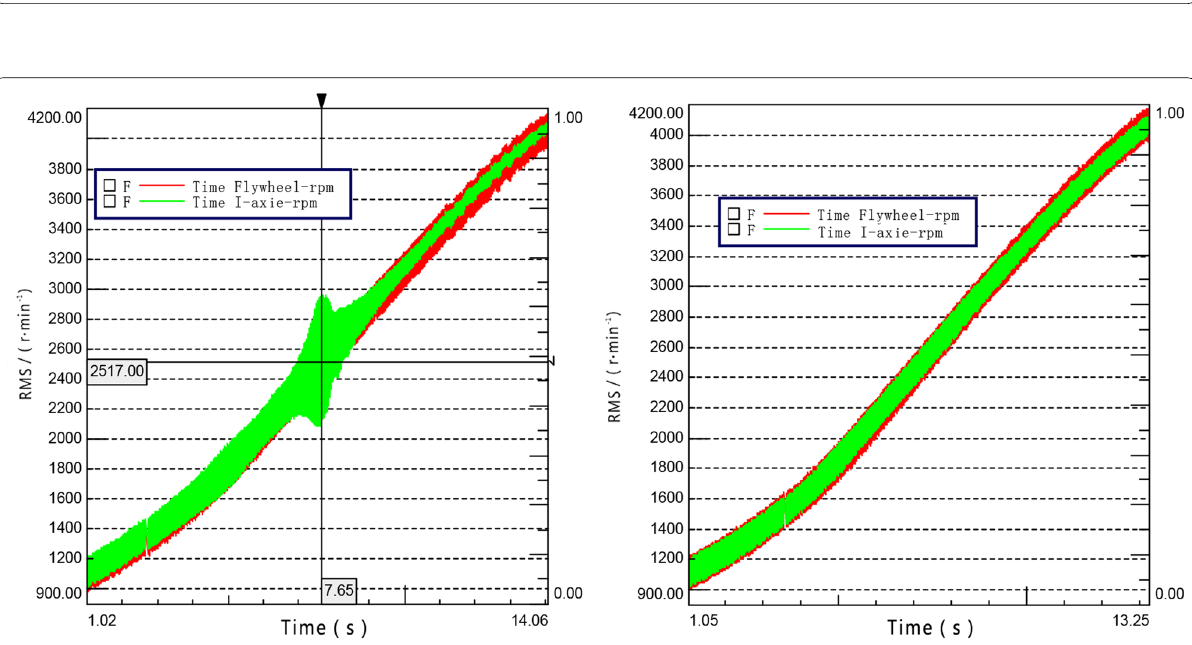
Figure 14 Flywheel and first shaft speed fluctuations under full acceleration in second gear (left: traditional clutch; right: wide-angle, large-hysteresis, multistage damping